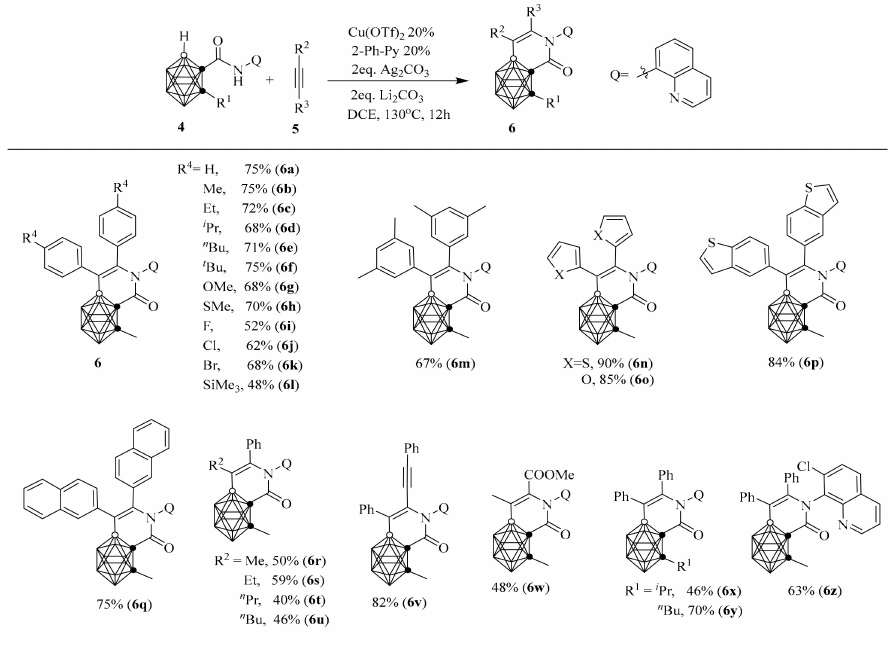
Figure 2. Synthesis of o -carborane-fused